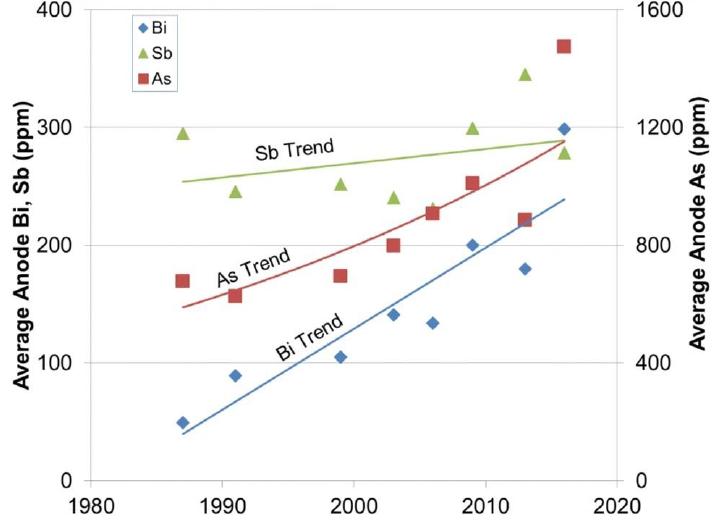
Figure 7. The evolution of the presence of As, Sb, and Bi as impurities in copper anodes over the last 30 years worldwide [101].